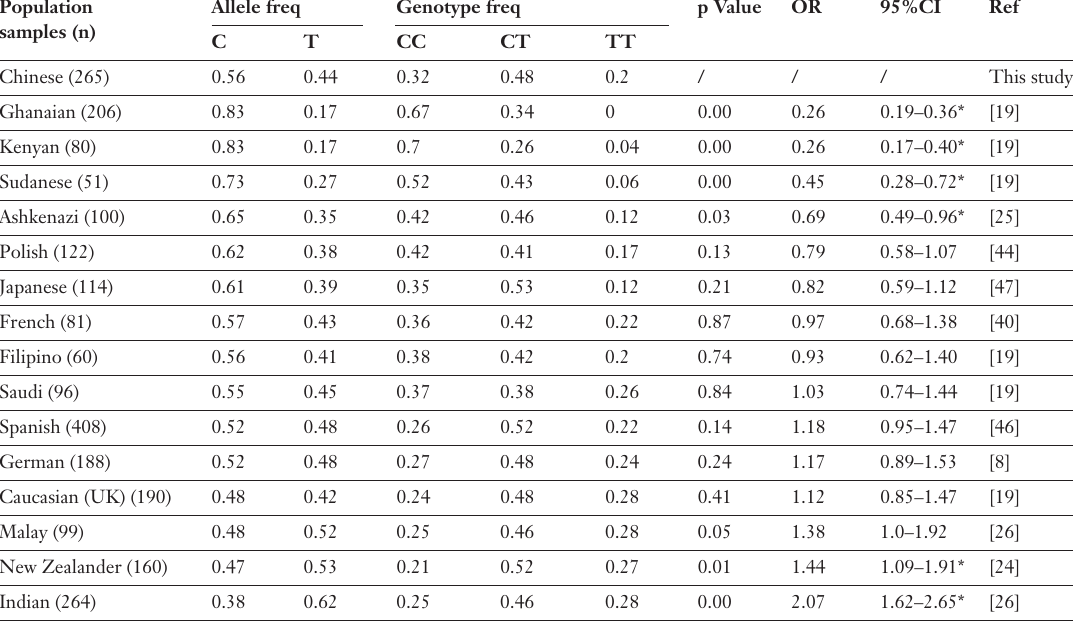
* Data showing significant significances are in bold print. The C allelic frequency of the Chinese serves as control.